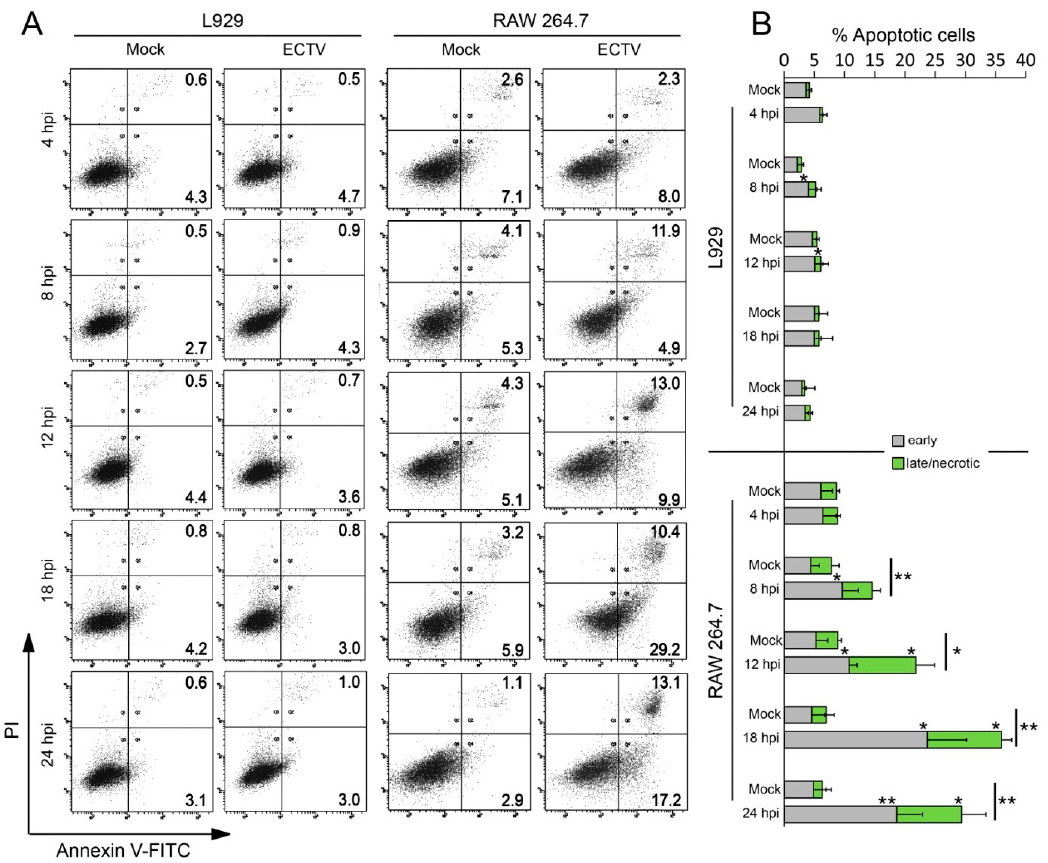
Figure 13. Apoptotic rate in RAW 264.7 and L929 cells during ECTV infection. ( A ) Representative double fluorescence dot plots of flow cytometry analysis of Anexin V- fluorescein isothiocyanate (FITC) and propidium iodide (PI) staining in RAW 264.7 and L929 cells at 4, 8, 12, 18, 24 hpi with ECTV. ( B ) The percentage of early and late apoptotic or necrotic cells. Student’s t -test; * p < 0.05, ** p < 0.01.